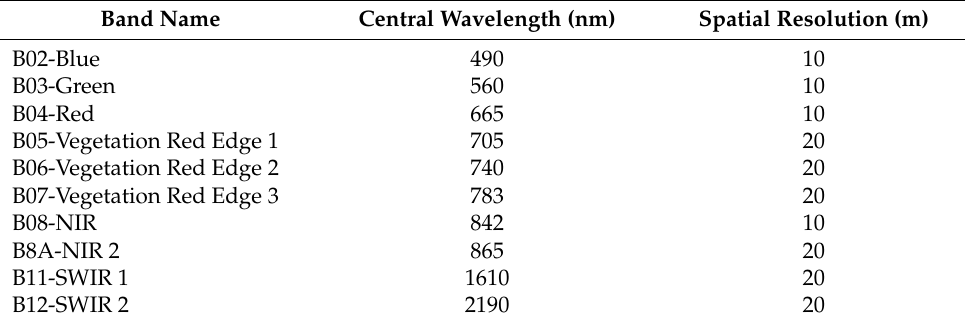
Table 2. Sentinel-2 bands analyzed in this study.